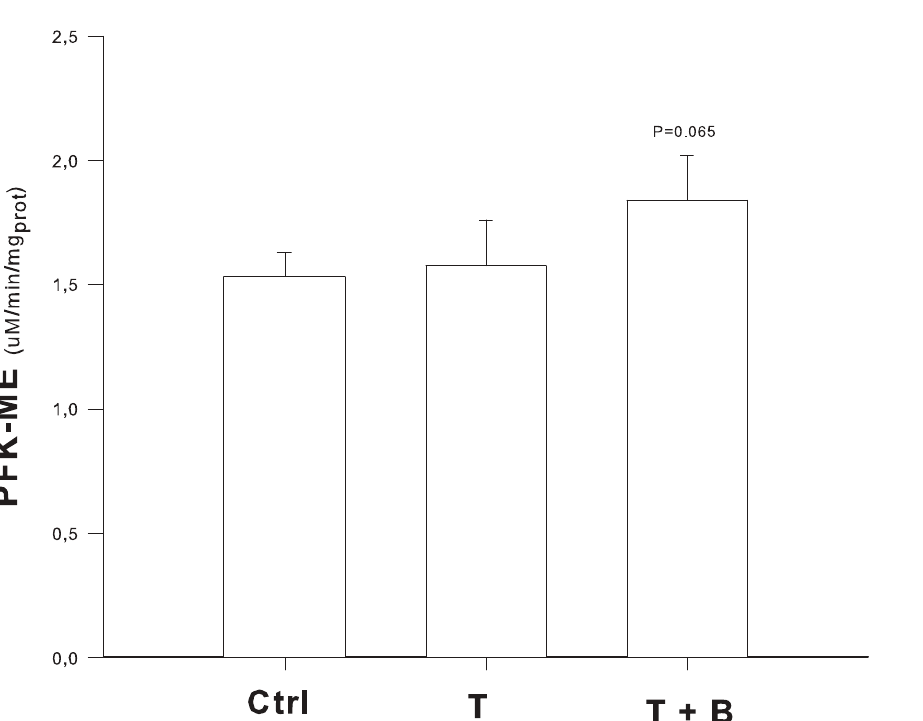
Figure 5. PFK activity. Activity of the glycolytic enzyme phosphofructokinase (PFK) in the glycolitic muscle (ME- extensor digitorum longus) was slightly higher when bicarbonate was infused (P=0.067). Ctrl=end of lactic acid infusion (i.e 75 9 after the start of acid load).